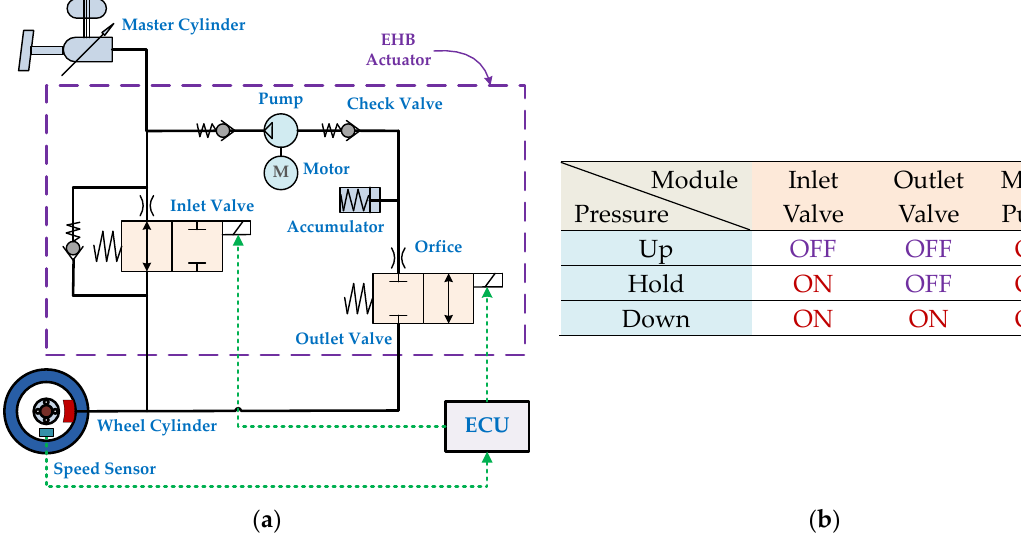
Figure 2. The control circuit of an EHB actuator: ( a ) structure; and ( b ) ABS control mode.